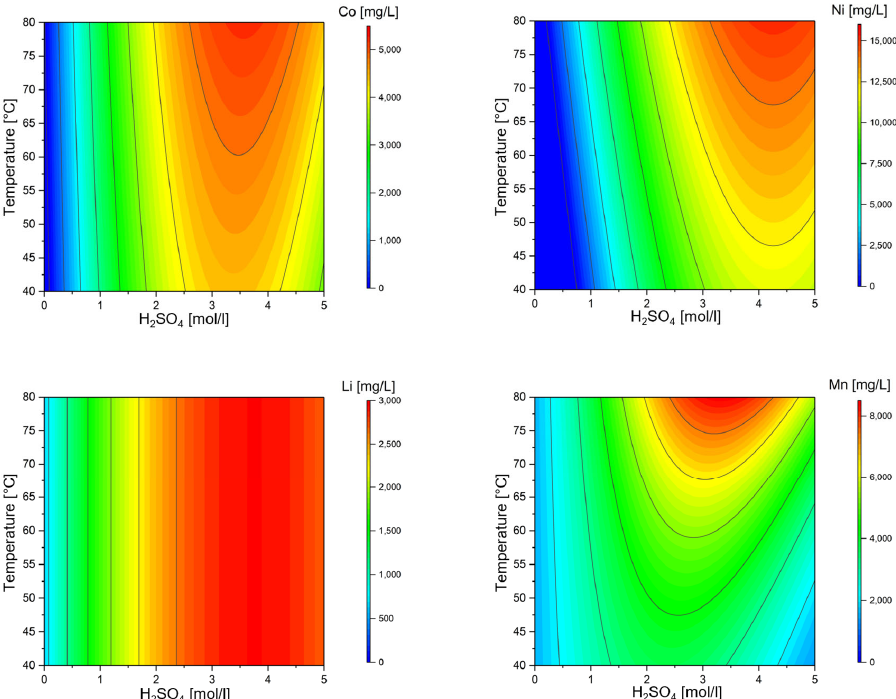
Figure 10. Contour plot of the statistical test evaluation for the leached fractions of Co, Ni, Li and Mn with addition of the maximum amount of Si met and SiO 2 without the application of H 2 O 2 and an S/L ratio of 50 g/L as a function of temperature and H 2 SO 4 concentration.